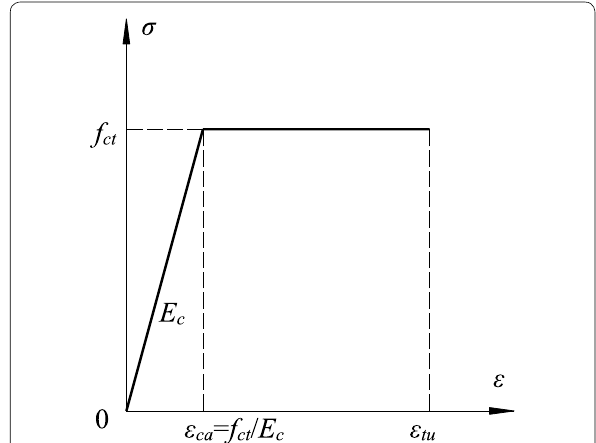
Fig. 20 Tensile model of UHPC for the calculation of ultimate capacity.